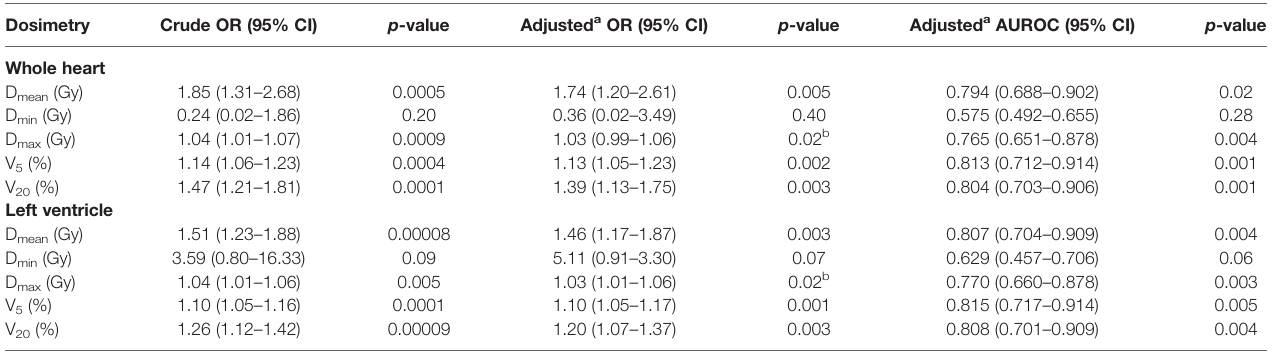
TABLE 6 | Relationship between dose-volume parameters and a relative reduction of GLS >15% occurring 6 months after BC RT highlighted by binary logistic regressions and ROC analyses ( n = 186 patients from the EARLY-HEART cohort). Dosimetry Crude OR (95% CI) p